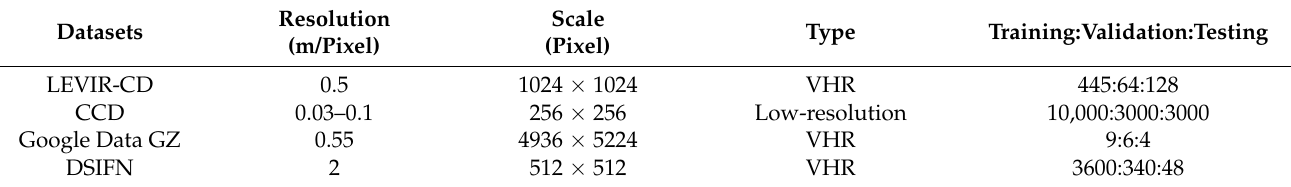
Table 2. Datasets’ attributes. VHR indicates very high